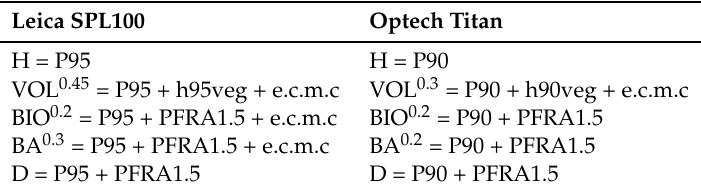
Table 2. Models used for estimation of forest variables.